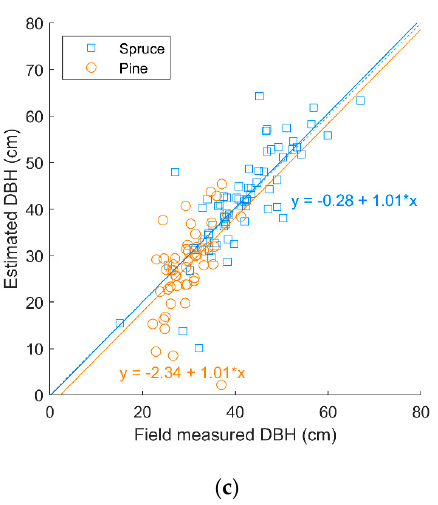
Figure 7. Field-measured vs. estimated diameters: ( a ) Hough transform; ( b ) RANSAC; ( c ) RLTS. Black dashed line expresses the 1:1 trend.